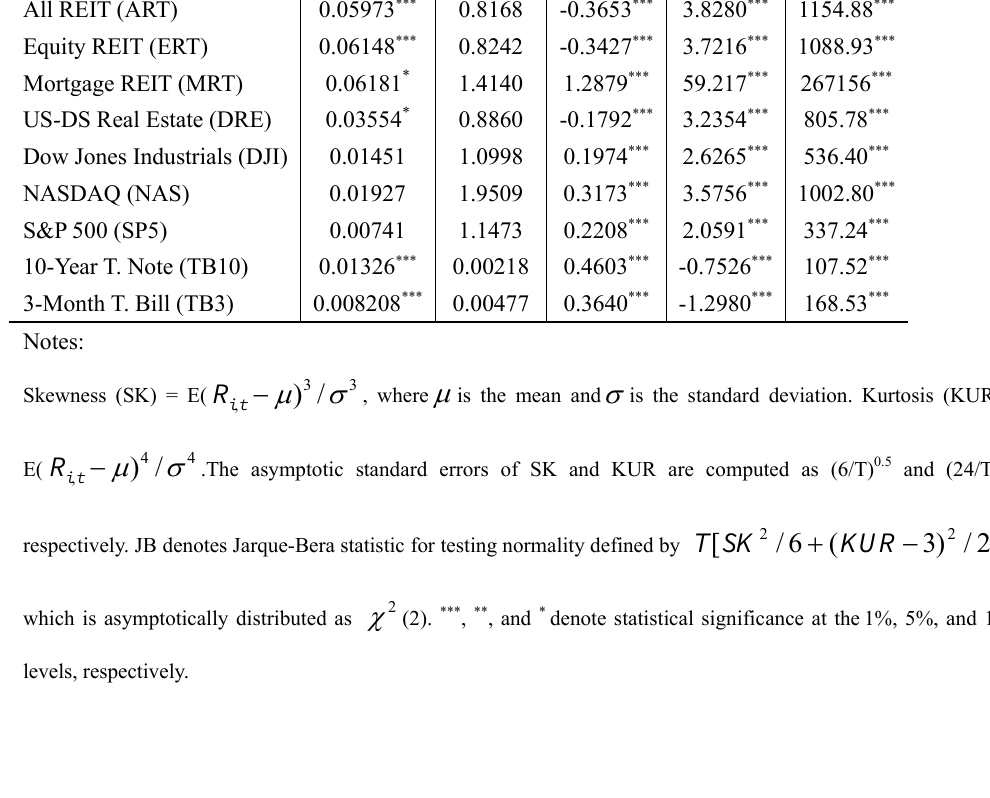
Table 1. A Summary of Descriptive Statistics for Various Asset Returns (1999–2005)